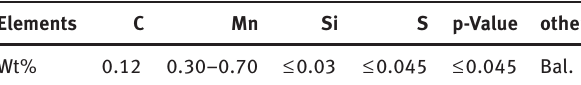
Table 1 The chemical composition of Q235B mild steel (wt%). Elements